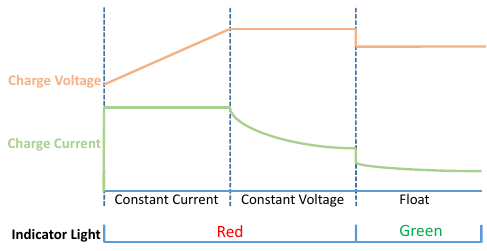
Figure 2. 3-stage